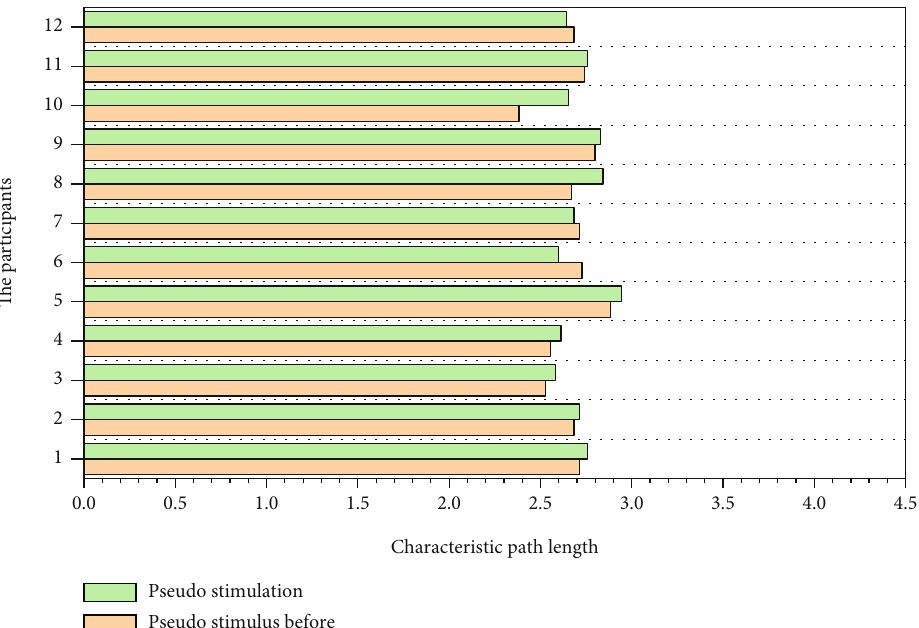
Figure 7: Network characteristic path length before and after pseudostimulus.